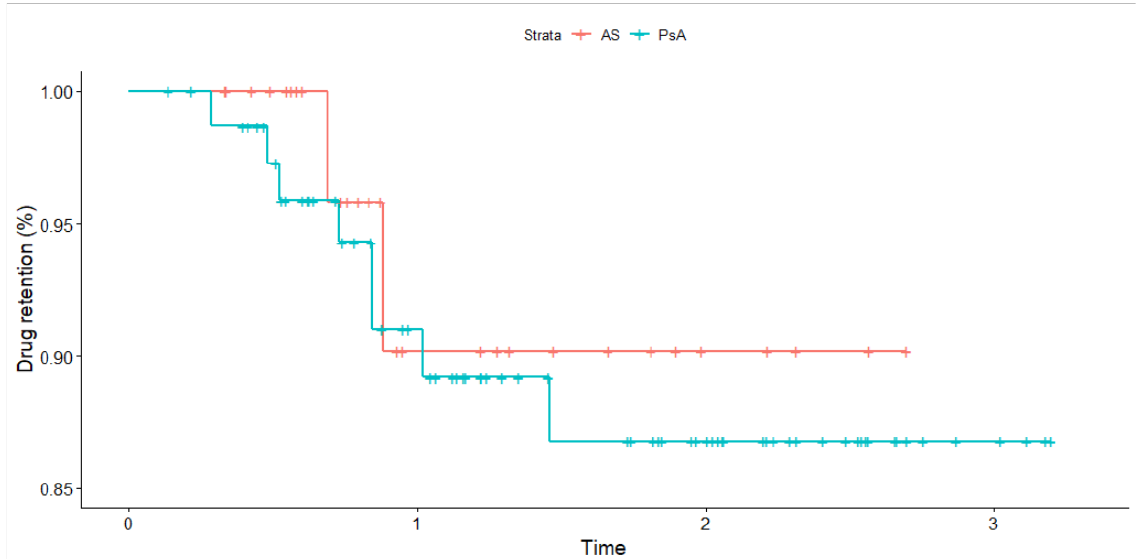
Figure 2. Crude Kaplan – Meier survival curve for drug retention compared across disease types for patients receiving secukinumab in first-line. Time is expressed in years. The p -value based on the log-rank test is 0.68. Tick marks indicate censored events.